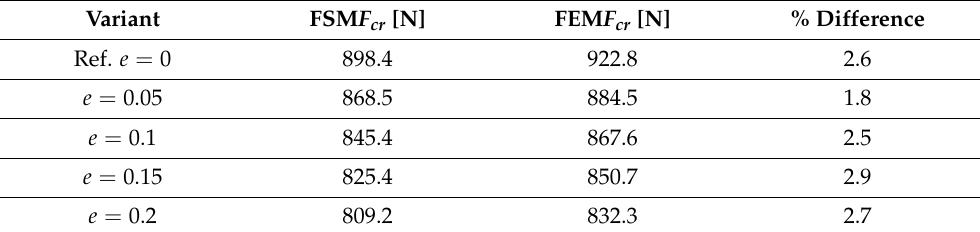
Table 6. Computed values of critical forces by FSM and FEM.